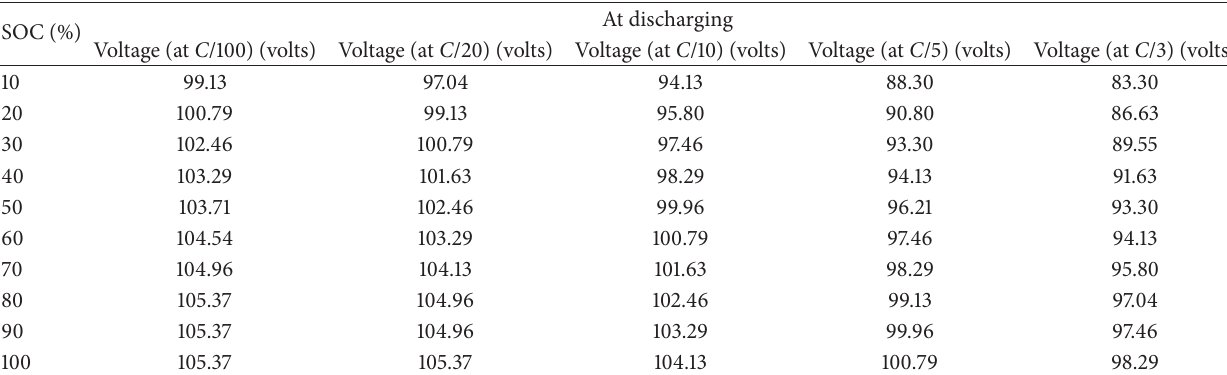
Table 2: SOC versus terminal voltage at various discharge